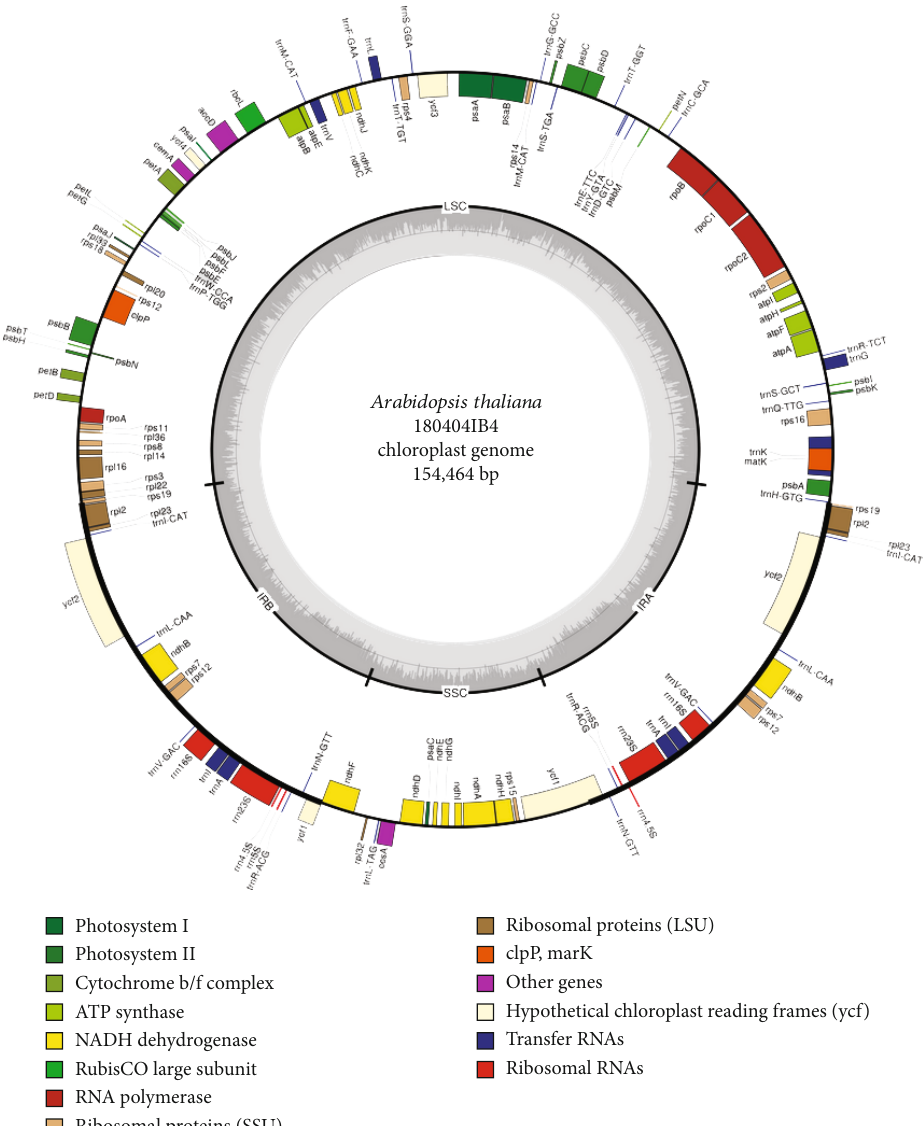
Figure 1: Complete chloroplast genome of Korean isolate of A. thaliana , 180404IB4. The genes located outside of the circle are transcribed clockwise, while those located inside are transcribed counter clockwise. The dark grey plot in the inner circle corresponds to GC content. Large single copy, small single copy, and inverted repeat are indicated with LSC, SSC, and IR (IRA and IRB),